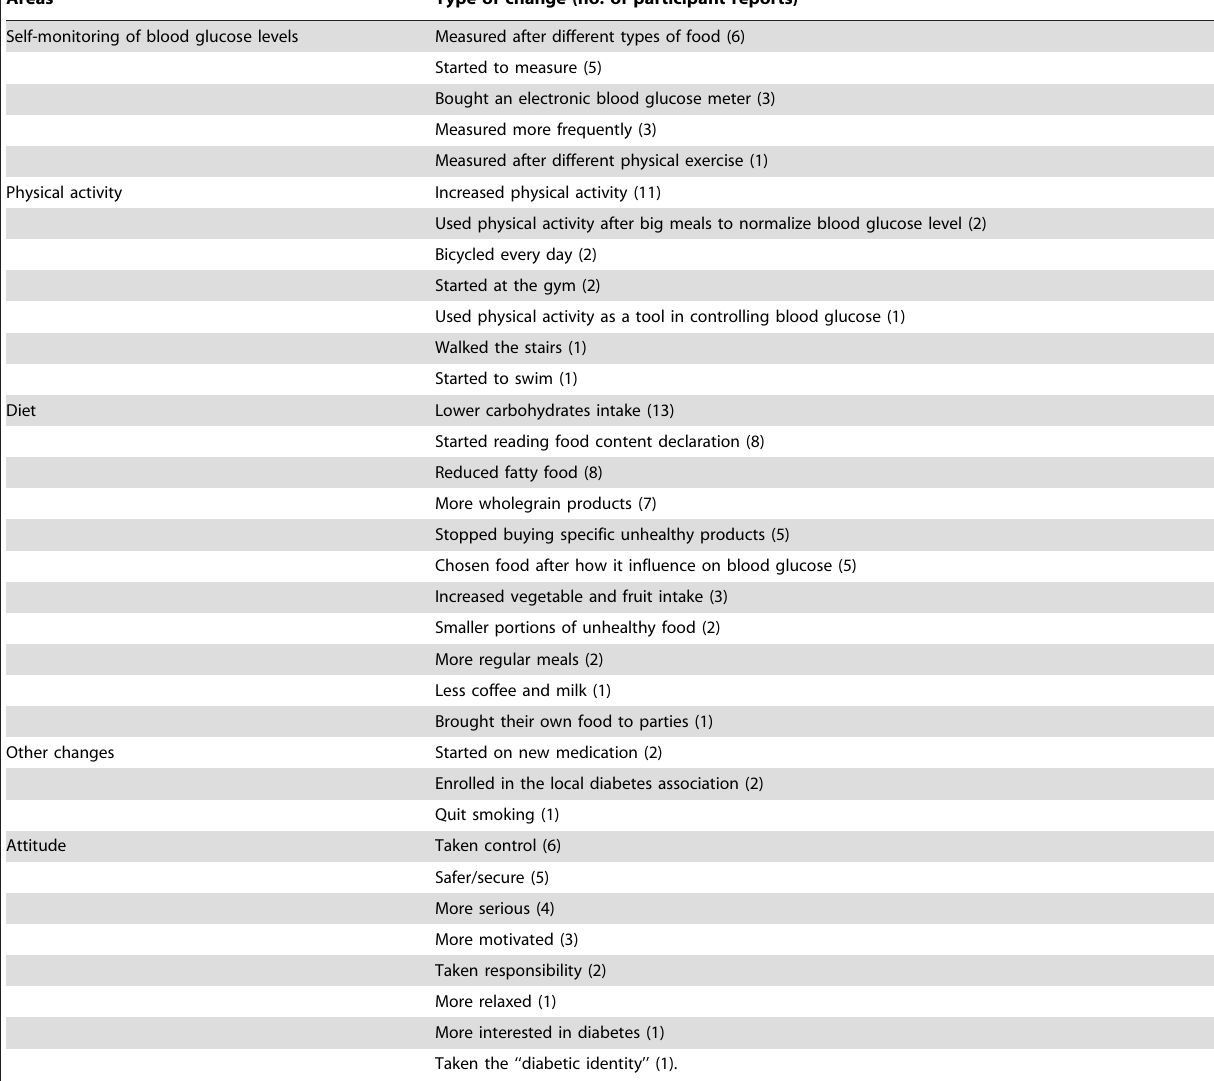
Areas Type of change (no. of participant